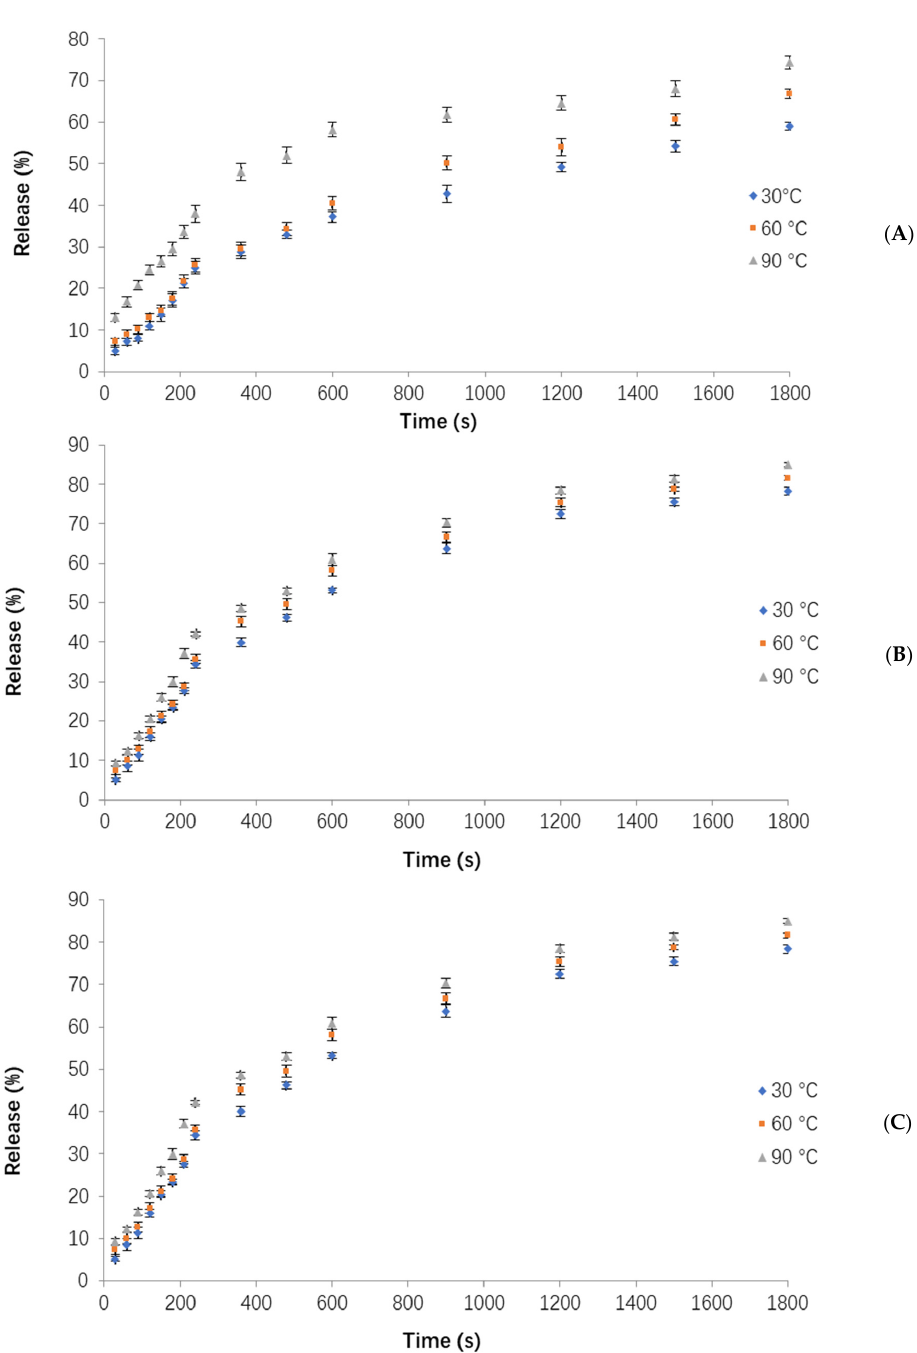
Figure 5. The release of orange peel oil from powders at pH = 7 and different temperatures (30, 60, 90 °C): ( A ) NC3, ( B ) NC6, ( C ) NC9.